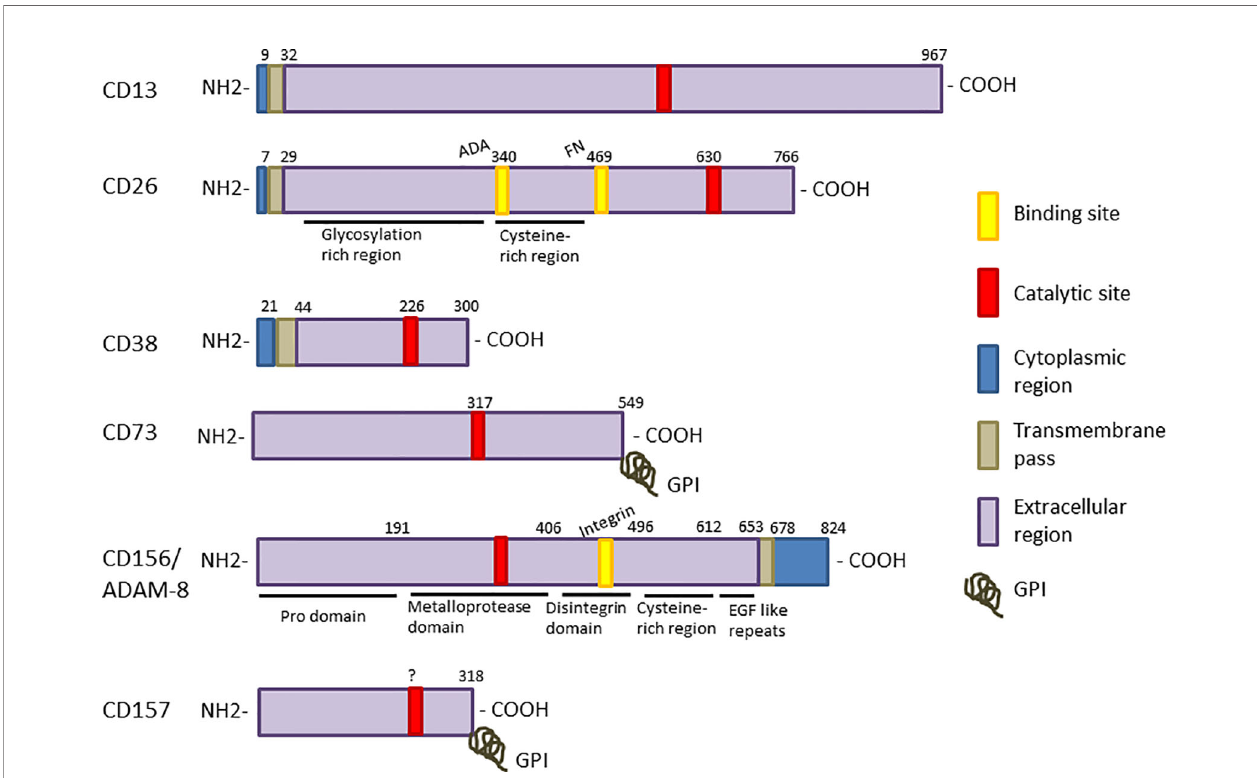
FIGURE 1 | Linear representation each enzyme sequence. The different regions are displayed as color boxes: catalytic sites are red and the known binding sites for speci fi c substrates, yellow. Intracellular regions are shown in blue, trans-membrane regions are represented as grey boxes, and extracellular regions are shown in purple. CD73 and CD157 are bound to the membrane through a glycosylphosphatidyl inositol molecule (GPI), symbolized by a grey coil. CD156/ADAM-8 is the only enzyme with signal transduction motifs (SH3 binding domains) in the cytoplasmic